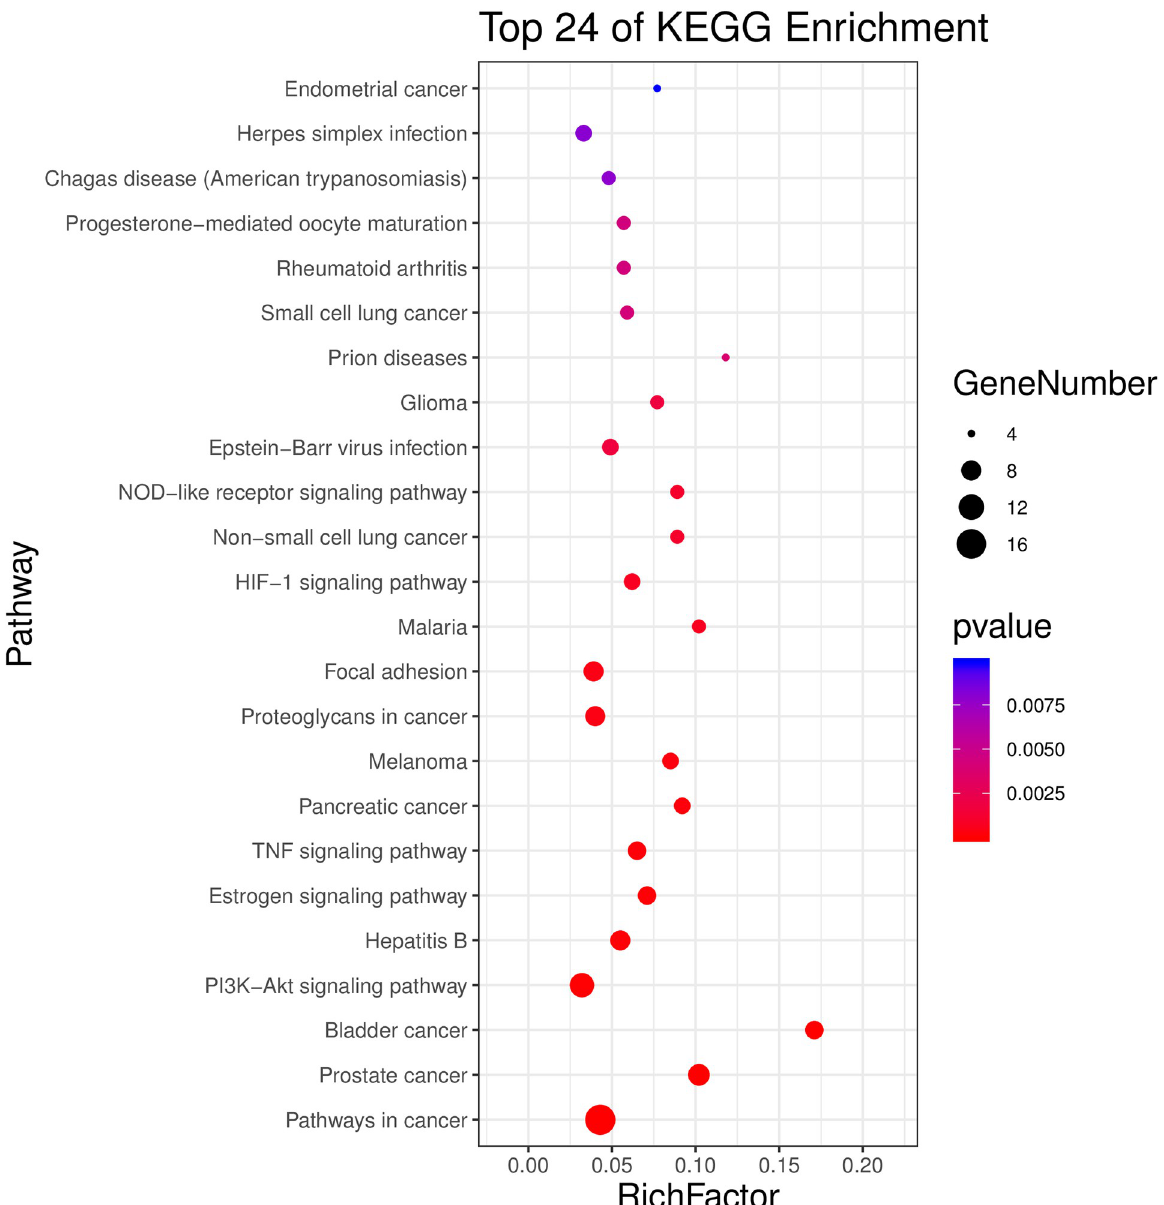
Fig 5. KEGG. 33 overlapped genes was analysis by KEGG, which enriched in 24 pathways. The darker the color, the greater the weight, and the larger the circle, the greater the